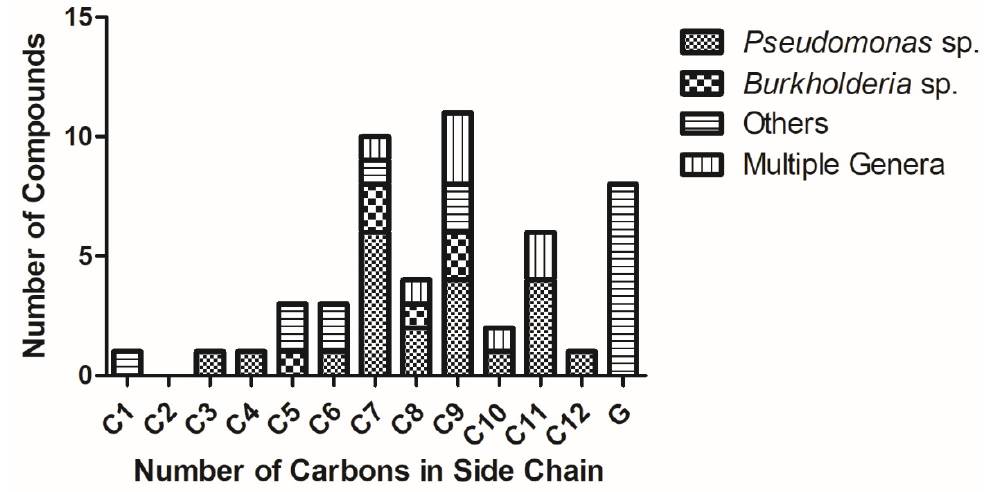
Figure 3. Number of individual isolated alkylquinolones (from all classes) reported vs number of carbons in side-chain (x-axis) from different genera. G = geranyl-derived side chains.